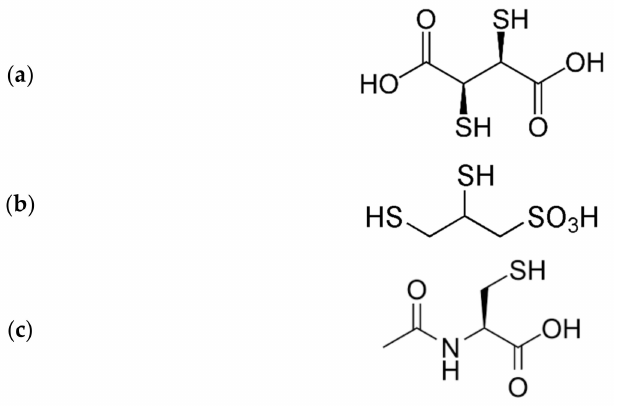
Figure 2. Molecular formulae of ( a ) DMSA, ( b ) DMPS and ( c )